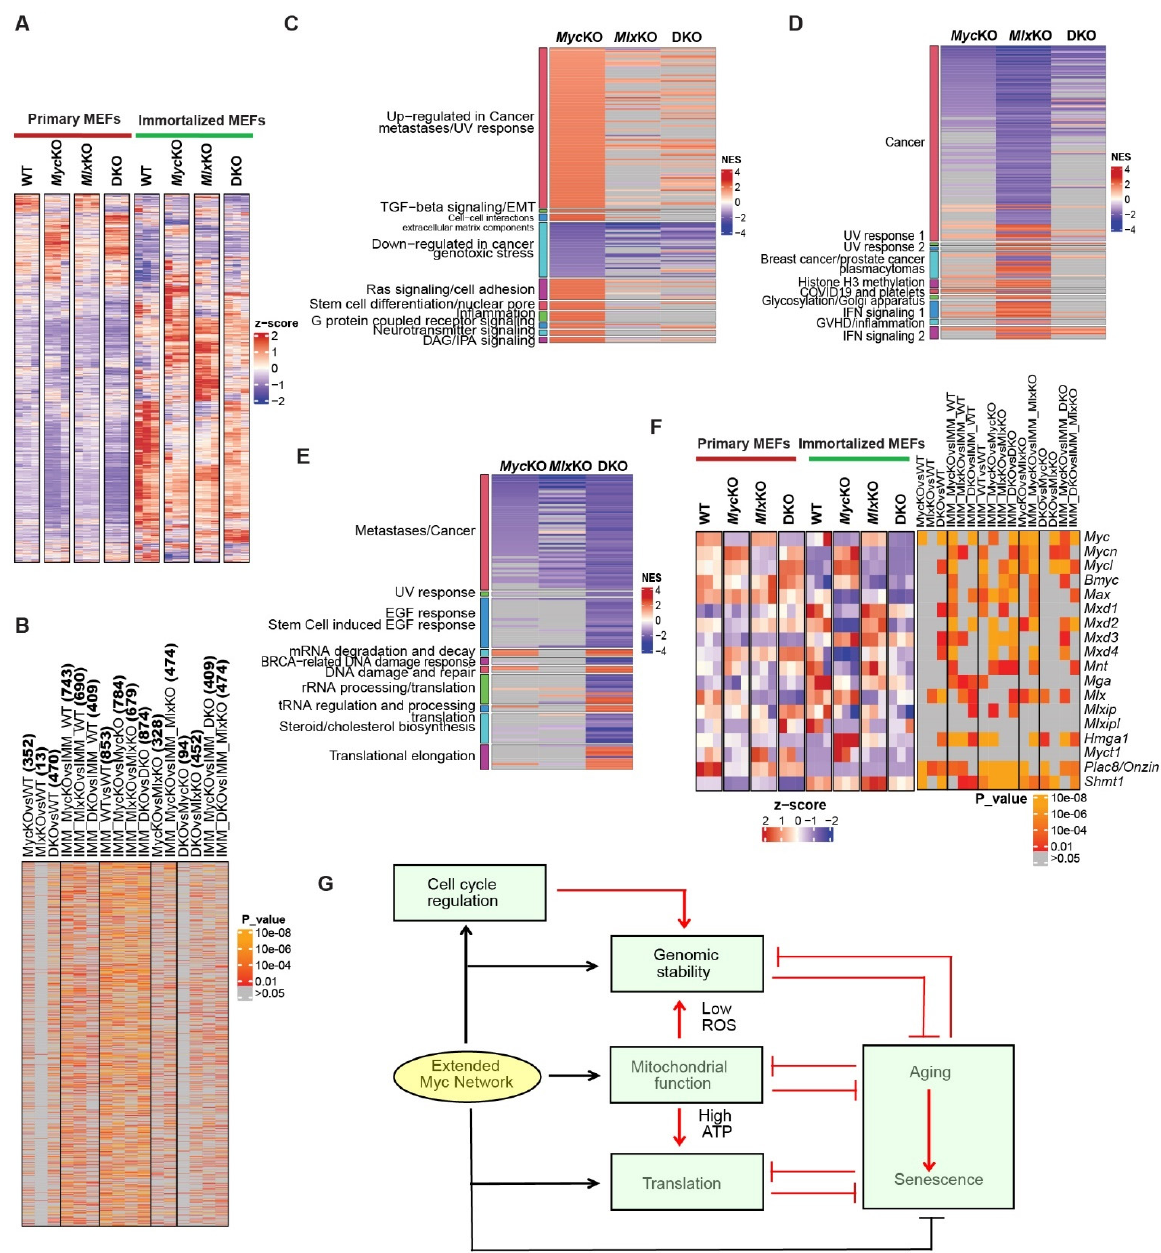
Figure 8. RNA-Seq analyses of immortalized MEFs: ( A ) Expression profiling (z-scores) of all 1519 unique transcripts encoding proteins involved in DNA damage recognition/repair from the MSigDB C2 database in primary and immortalized MEFs. ( B ) Significant differences in the expres- sion levels of the transcripts depicted in ( A ) among pairwise comparisons of primary and immor- talized MEFs. The pairwise comparisons represented by each column are indicated at the top of each column, with the number of significant gene expression differences ( q < 0.05) shown in bold. Note that all four immortalized MEF cell lines contain significantly more gene expression differ- ences relative to their WT counterparts (columns 7–10). ( C ) Major categories of gene sets enriched in immortalized Myc KO MEFs. GSEA was performed using gene sets obtained from the MSigDB C2 database and clustered using the Bioconductor clusterProfiler tool (https://bioconduc- tor.org/packages/release/bioc/html/clusterProfiler.html (accessed on 14 August 2022)). Heatmaps were drawn using the ComplexHeatmap tool, also from the Bioconductor website